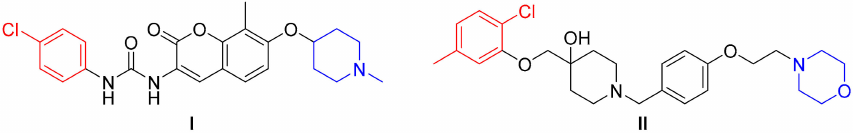
Figure 1. Two known Hsp90 C-terminal-domain inhibitors, ( I ) and ( II ), that feature a cationic center and aromatic ring at the opposite ends of their structures